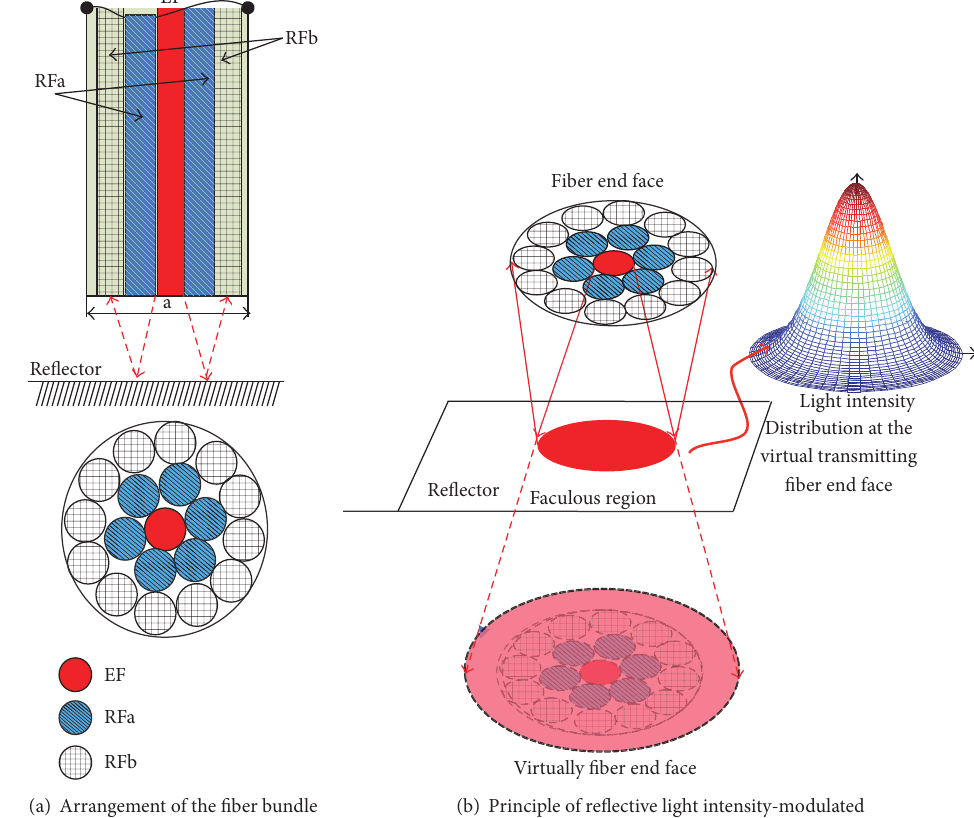
Figure 4: Structure of the reflective intensity-modulated optical fiber